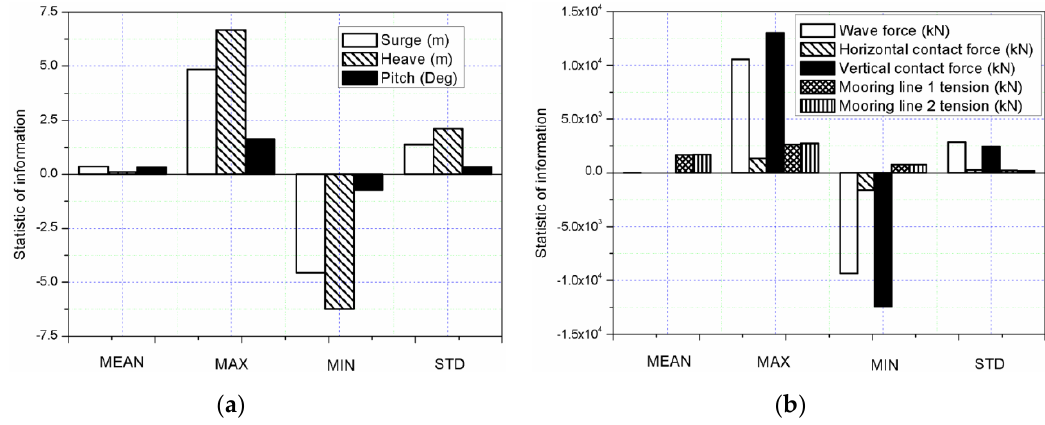
Figure 20. Statistical values of the responses for the extreme sea state LC4: ( a ) statistic of information for semisubmersible surge, heave and pitch; ( b ) statistic of information for wave force of the combined structure, horizontal contact force, vertical contact force, mooring line 1 tension and mooring line 2 tension.